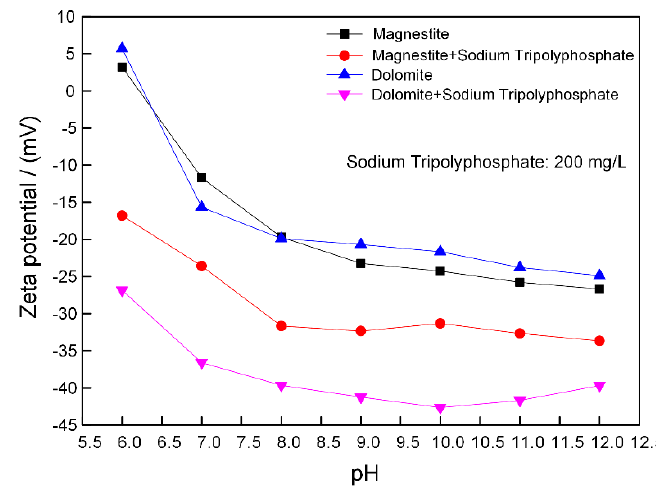
Figure 9. Zeta potential measurements for magnesite and dolomite with and without treatment of sodium tripolyphosphate.